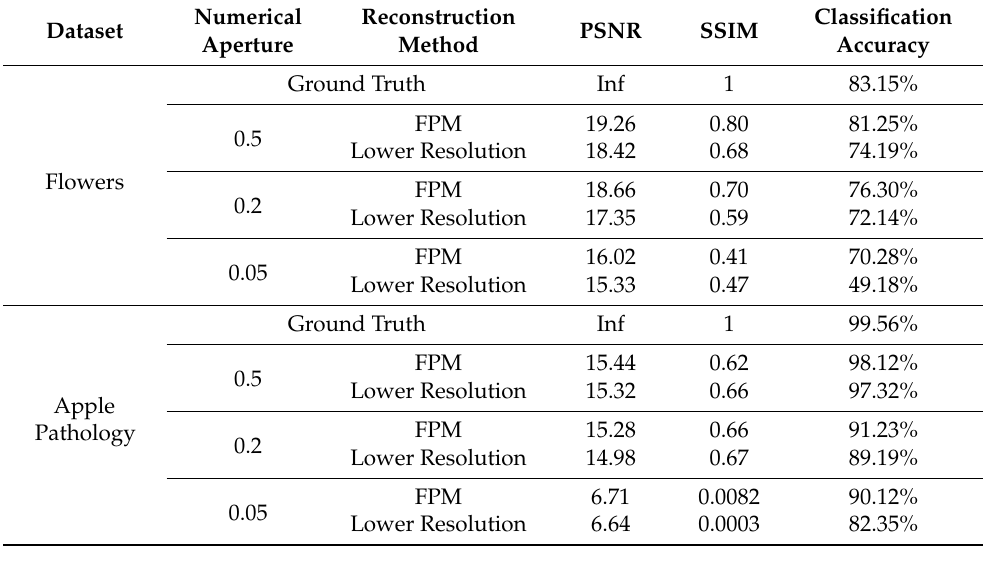
Table 3. PSNR, SSIM, and classification accuracy for flowers and apple pathology datasets .